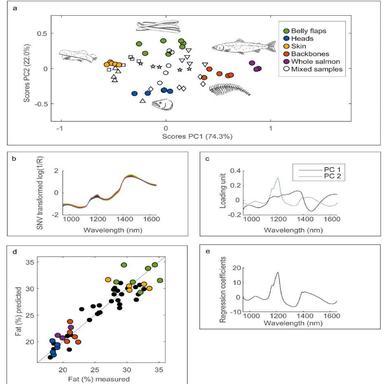
Results from characterisation of different ground salmon raw material categories by near infrared spectroscopy. (a) Score plot from a PCA of SNV transformed NIR spectra of whole salmon, backbones, skin, heads, belly flaps and mixtures of the listed categories. (b) The NIR spectra presented as standard normal variate (SNV) transformed apparent absorption (log (1/Reflectance). (c) PCA loadings corresponding to the score plot in panel a. (d) Cross-validated predicted versus measured fat content from a calibrat